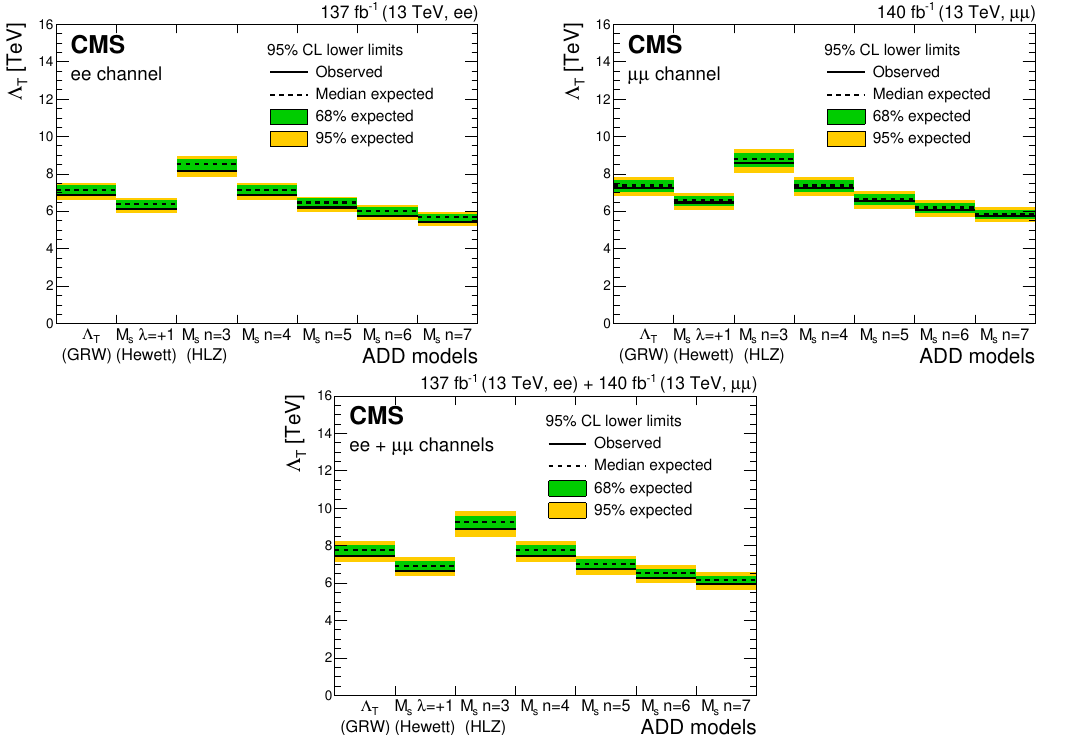
Figure 10 . Exclusion limits at 95% CL on the ultraviolet cutoff for (upper left) the dielectron channel, (upper right) the dimuon channel, and (lower) their combination, with m ( m > 1 . 9 TeV for 2016) in the GRW (first bin), Hewett (second bin), and HLZ conventions (third ‘‘ to seventh bin) for the ADD model. Signal model cross sections are calculated up to LO, and an NNLO correction factor of 1.3 is